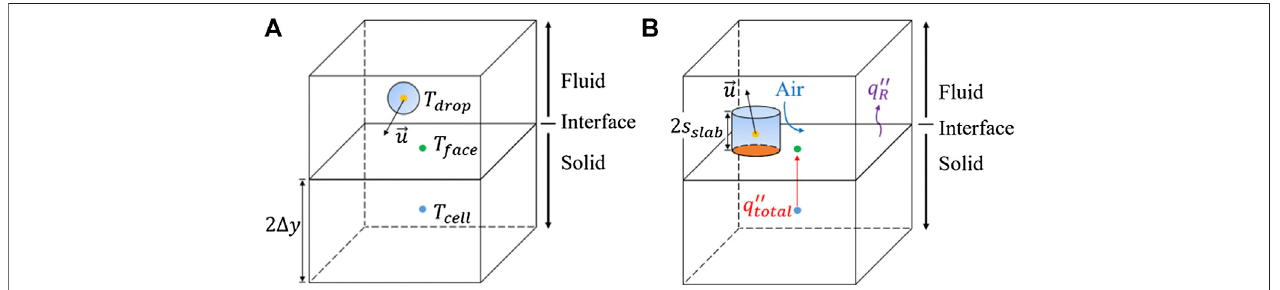
FIGURE 4 | Droplet-steel impingement heat transfer calculation (A) before impingement, and (B) after impingement.